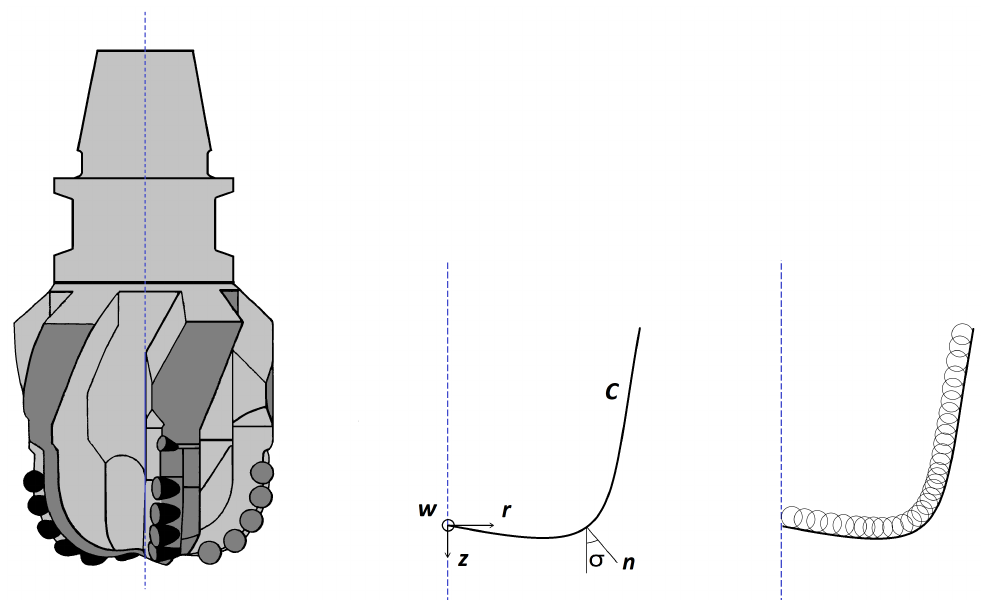
Figure 5. Sample PDC bit and the equivalent blade representation of the cutters; r , z , and w indicate the coordinate axis in radial, normal, and tangential directions, respectively; C is the bit profile curve; n is the normal direction to the bit profile and σ is the angle between normal to the bit profile and bit axis.